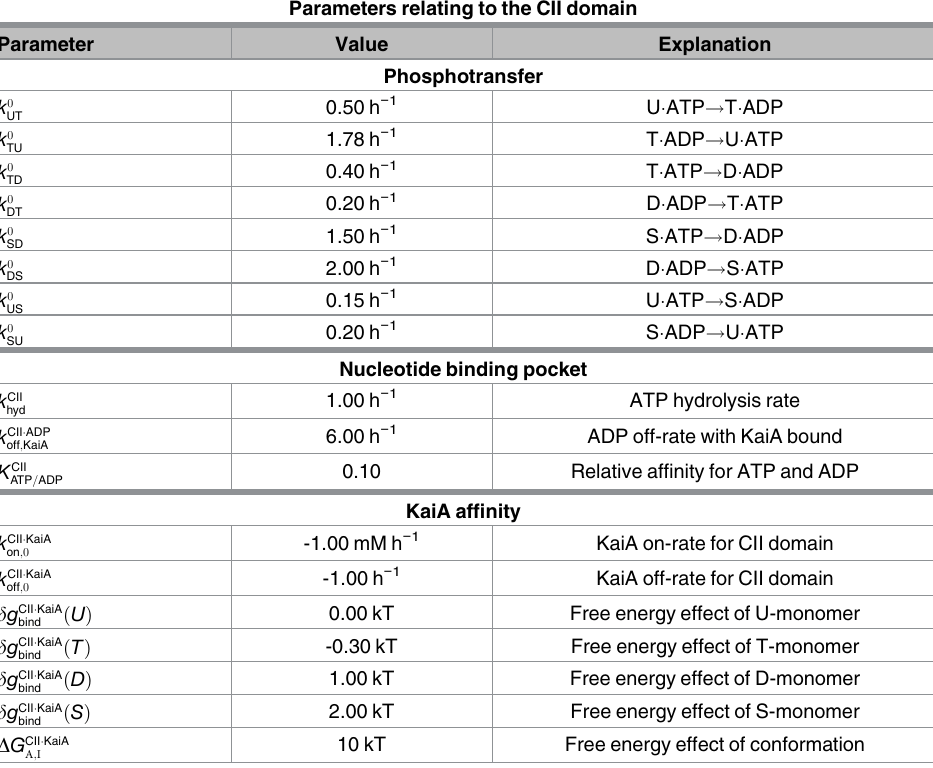
Table 2. Model parameters relating to the CII domain are introduced in the theory section on phos- phorylation dynamics and their values are motivated in the results section. Energiesare given in units of kT, were k is Boltzmann’s constant and T the